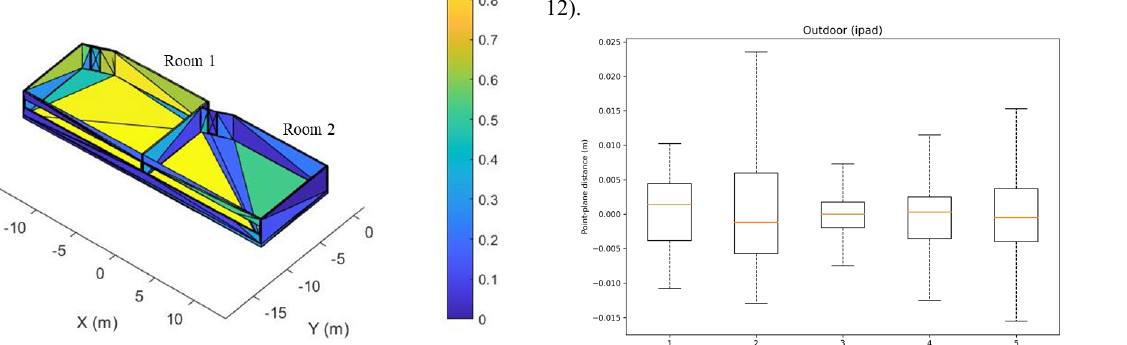
Figure 12 . Distribution of point-plane distances for the 5 planes tested from the iPad Pro point